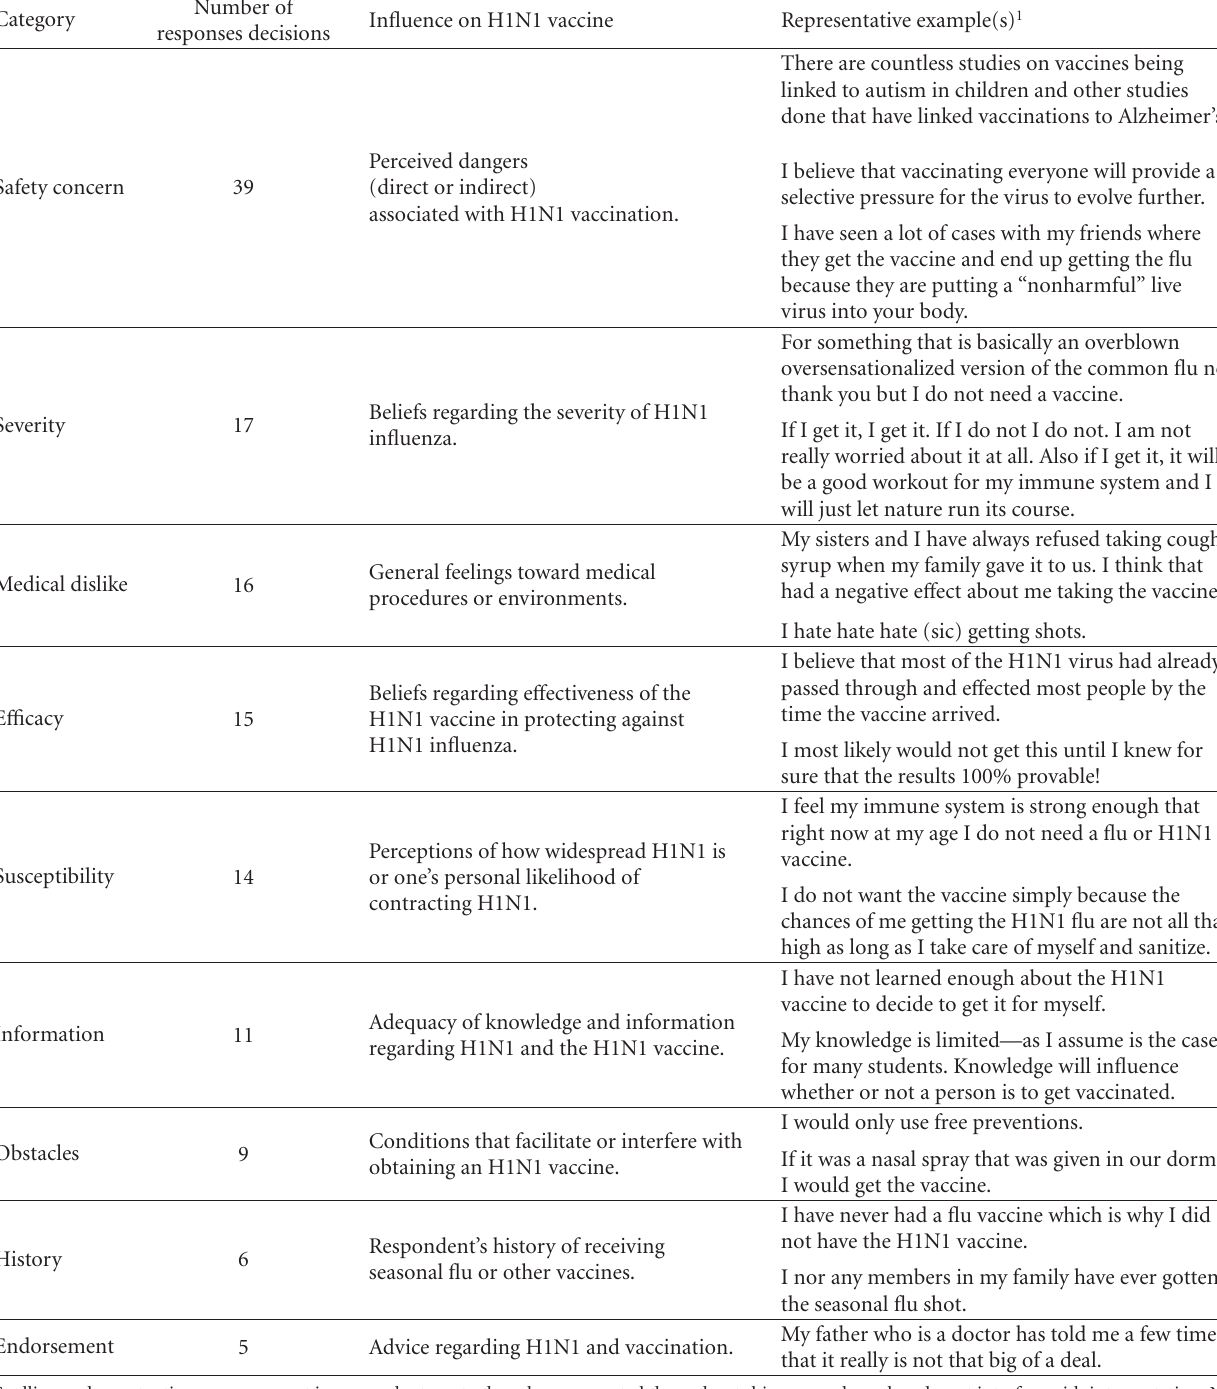
Table 2: Qualitative results: influences on H1N1 vaccine